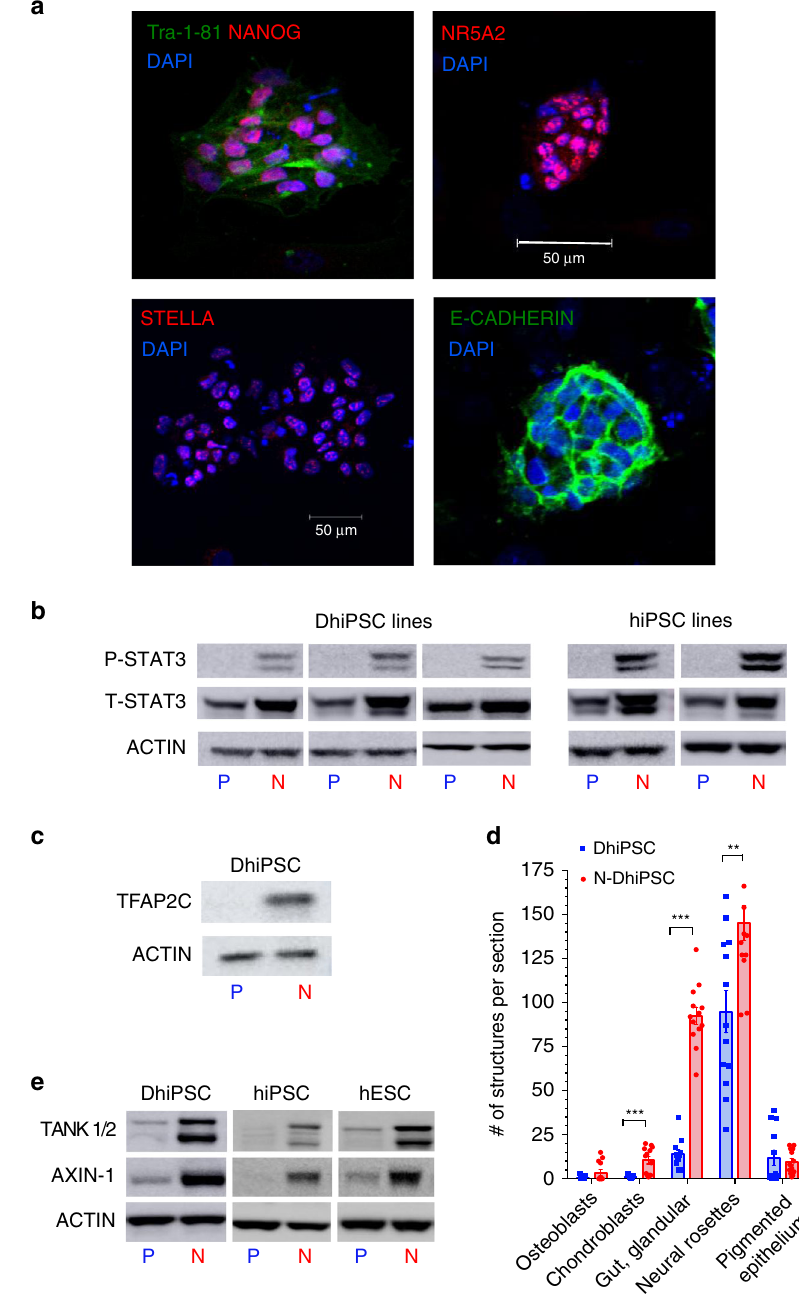
Fig. 2 Characterization of primed vs. naïve DhiPSC. a IF stains of N-DhiPSC (line E1C1) for general pluripotency factors (TRA-1-81, NANOG) and naïve pluripotency proteins (NR5A2, STELLA/DPPA3, E-CADHERIN; Scale Bar = 50 μ m). b Primed (P) vs. naïve (N) phosphorylated-STAT3 (P-STAT3) expression. Western blots were performed of isogenic P vs. N lysates of (left panel) three independent DhiPSC lines (E1C1, E1CA1, E1CA2), or (right panel) two independent non-diabetic fi broblast-hiPSC lines (C1.2, C2). ACTIN and total STAT3 (T-STAT3) served as internal loading controls. c Naïve-speci fi c protein expression of TFAP2C 31 in DhiPSC (E1C1) in P vs. N conditions. d Isogenic teratoma organoid quanti fi cations from DhiPSC (E1C1) cultured in primed (blue bar) vs. naïve (red bar) conditions. Shown are quanti fi cations per cross section of mesodermal (NG2 + chondroblast), de fi nitive endodermal (CK8 + gut/glandular cells), and ectodermal (SOX2 + neural rosettes; retinal pigmented epithelium) structures from H&E stained slides. ** p < 0.01; *** p < 0.001 (Mann-Whitney tests). e Western blots of XAV939-inhibited proteolysis of tankyrases 1 and 2 (TANK ½) and AXIN-1 proteins in isogenic primed vs. naïve conditions from DhiPSC (E1C1), and non-diabetic hiPSC (E5C3) and hESC